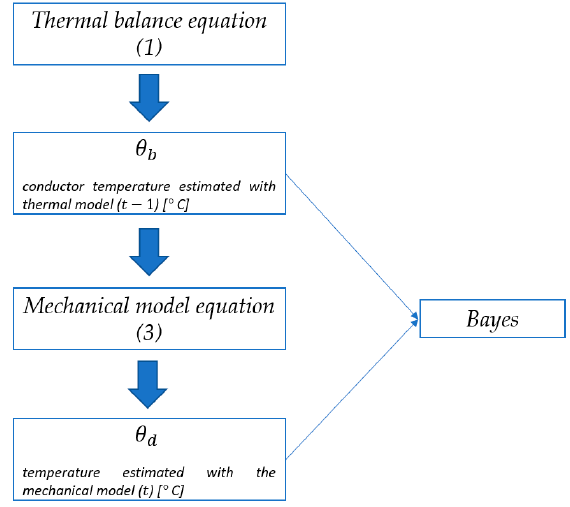
Figure 2. Methodological flow.